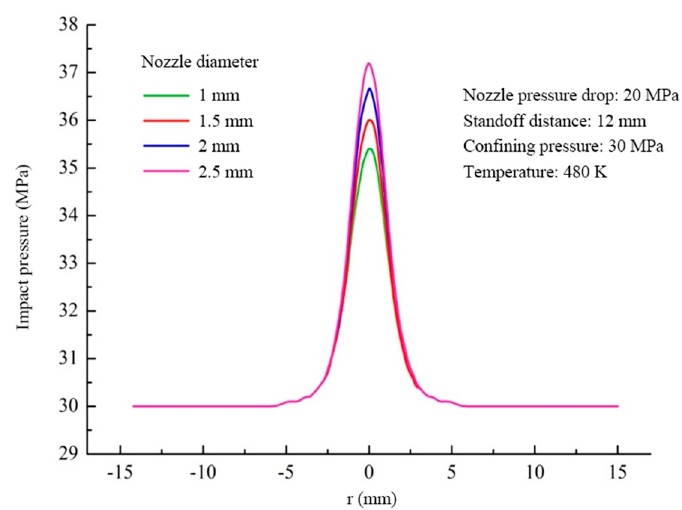
Figure 12. Influence of the diameter of the nozzle’s central hole on impact pressure.